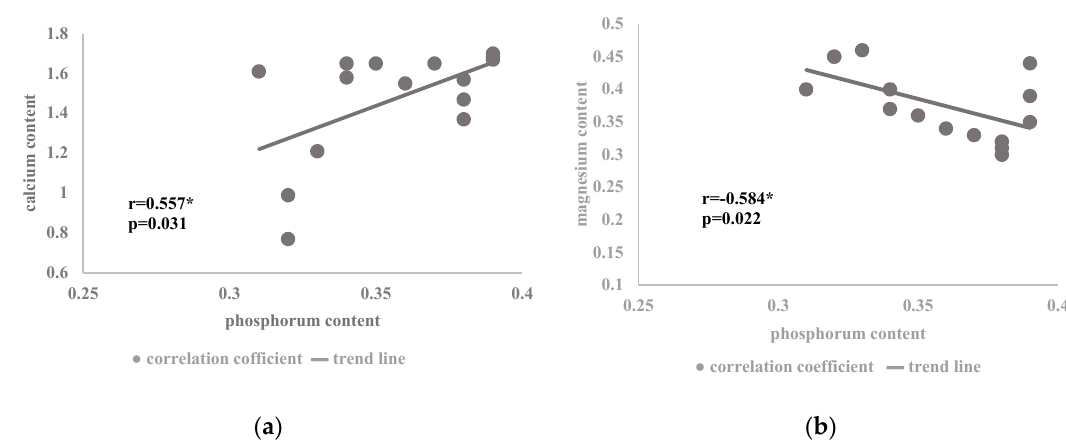
Figure 4. Coefficient of correlation between the content of phosphorus (% DM) and the content of ( a ) calcium and ( b ) magnesium (% DM) present in the mineral composition of the herb of the summer savory cv. Saturn in relation to the nitrogen dose and plant development phases (Table 2) (* correlation at p < 0.05).